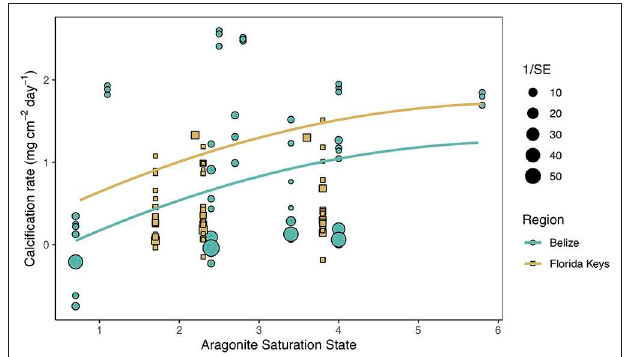
FIGURE 5 | Mean calcification rate (mg cm − 2 day − 1 ) of corals from each acidification study by treatment aragonite saturation state ( (cid:127) Arag ) with the linear mixed effects model quadratic fit by region and experimental duration (mean duration = 66.5 days). Shape and color of each point denote study region (blue circle = Belize; brown square = Florida Keys) and size of shape represents the weight (1/SE) of study.